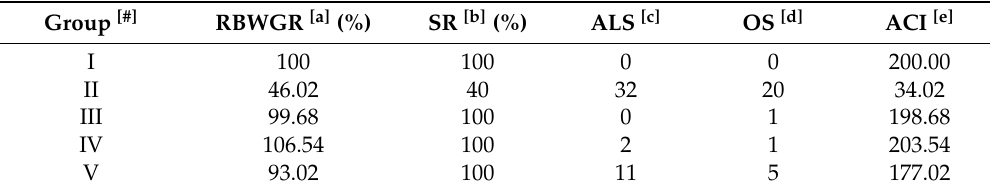
Table 2. Parameters for determination of anti-coccidial